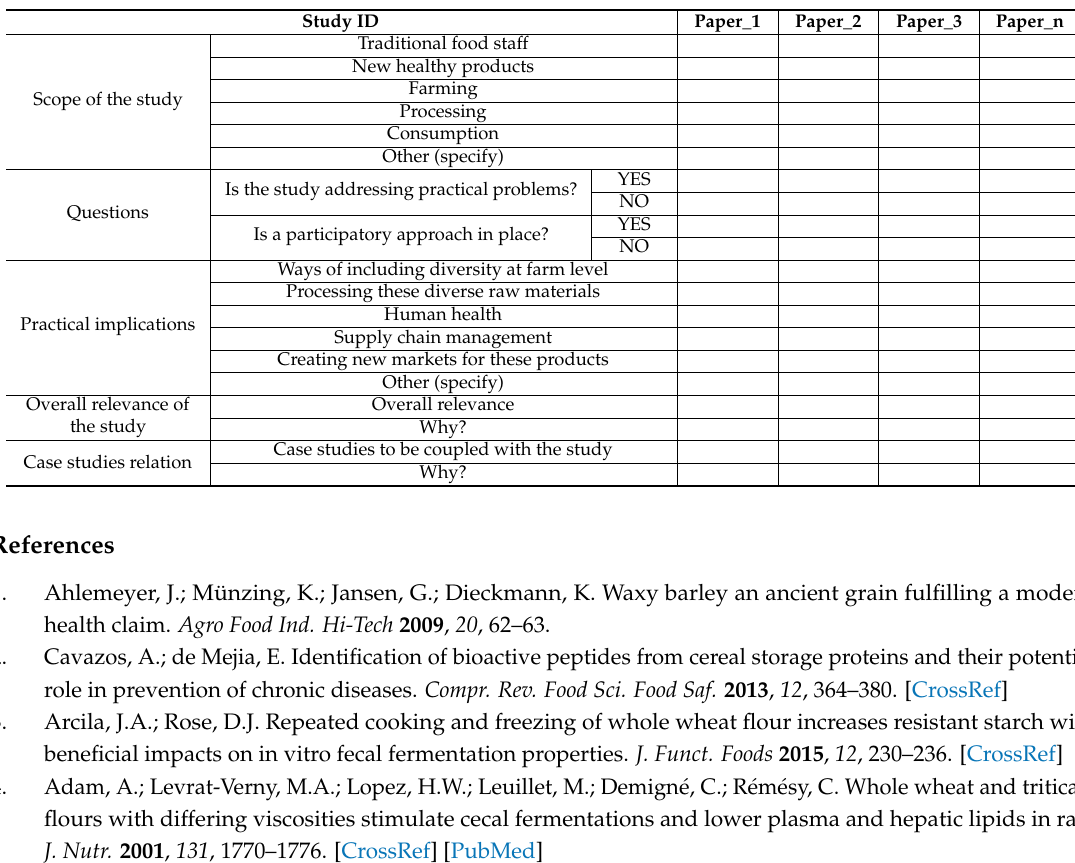
Table A4. Relevance